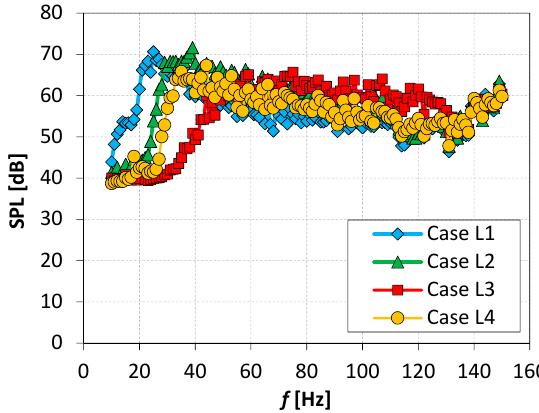
Figure 7. Sound pressure level generated at P = 4.0 W.